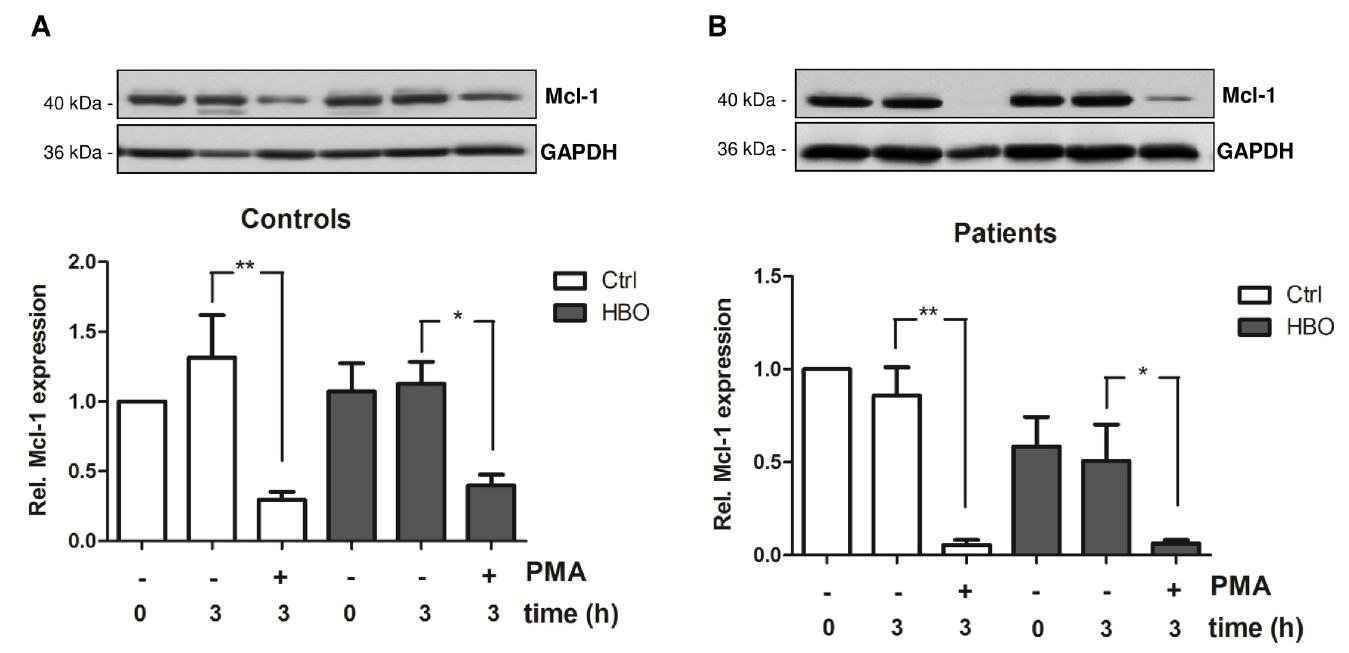
Fig 5. HBO does not alter the expression of antiapoptotic Mcl-1 protein. Neutrophils from healthy volunteers (Controls; n = 5) and polytraumatized patients (Patients; n = 4) were exposed to HBO (2.0 atm; 120 min) and further stimulated with PMA for 3 h. After that, Mcl-1 protein expression was quantified by western blot and normalized to GAPDH. Data are expressed as fold changes vs. control (0 h Ctrl, set as 1). * p < 0.05; ** p < 0.01